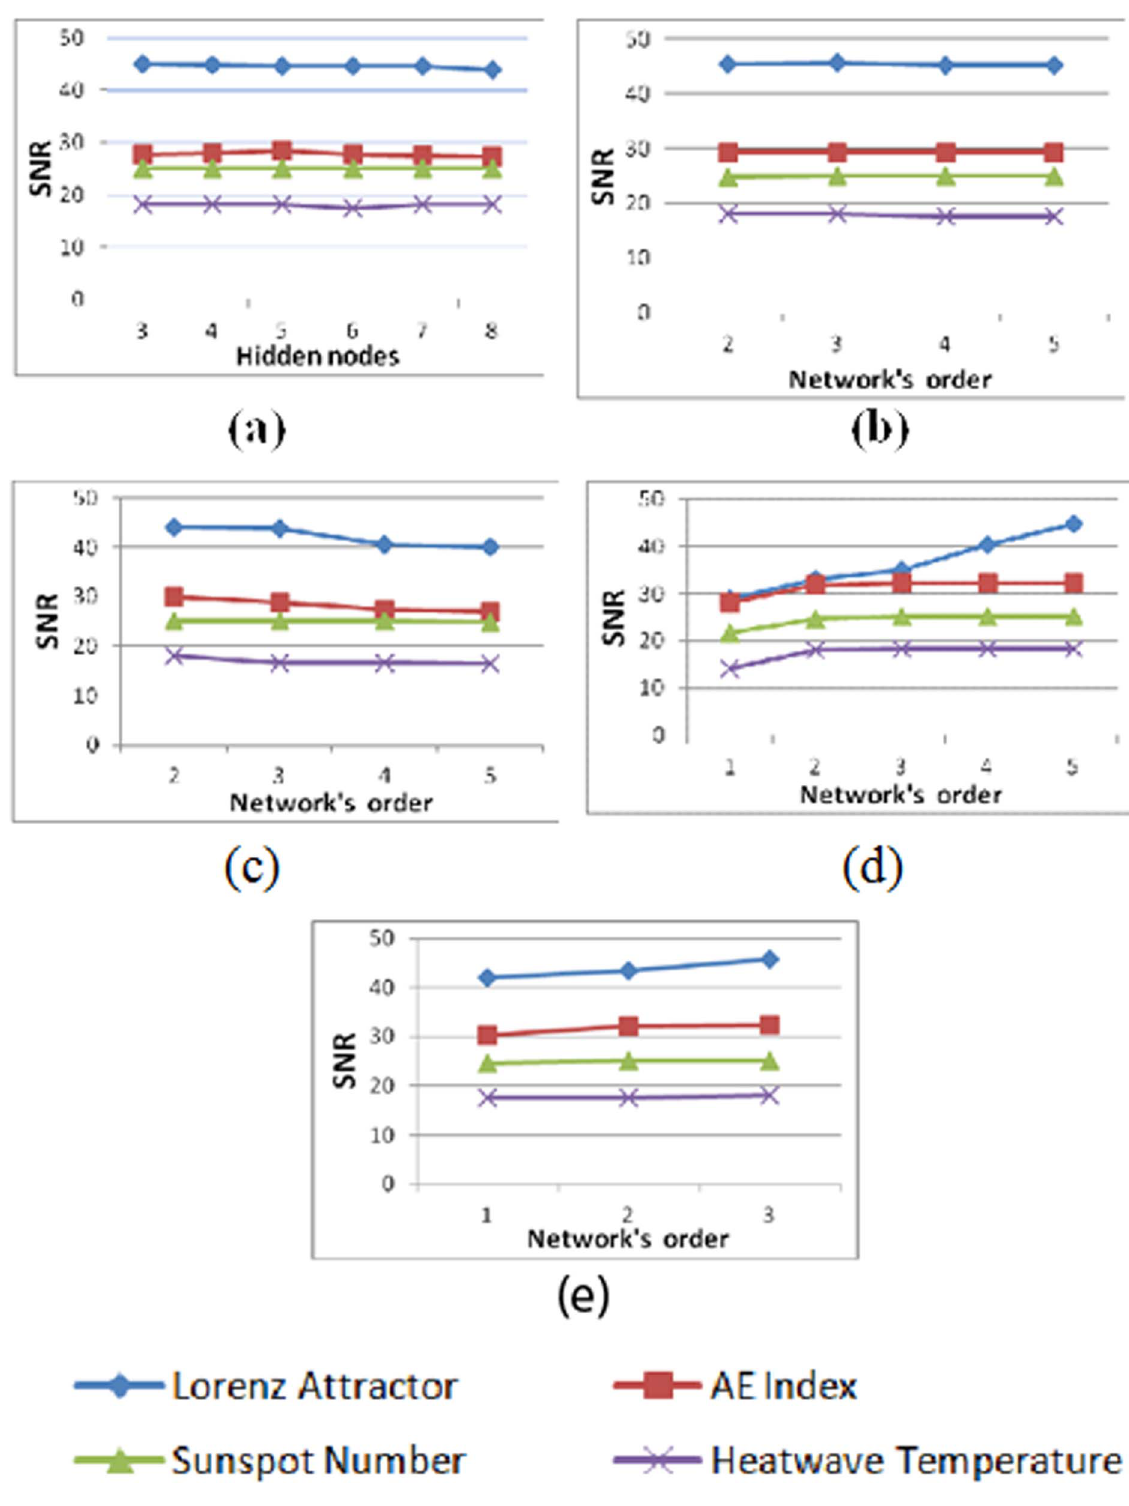
Figure 12. Performance of all networks with increasing order/number of hidden nodes (a) MLP, (b) FLNN, (c) PSNN, (d) RPNN, (e) DRPNN.